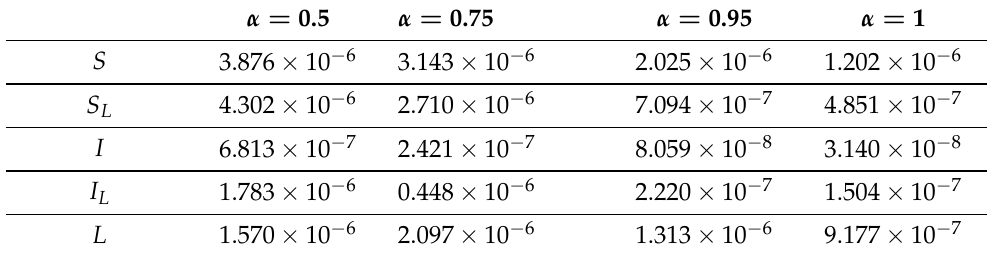
Table 3. Relative error of the state variables for different values of α when R 0 < 1.